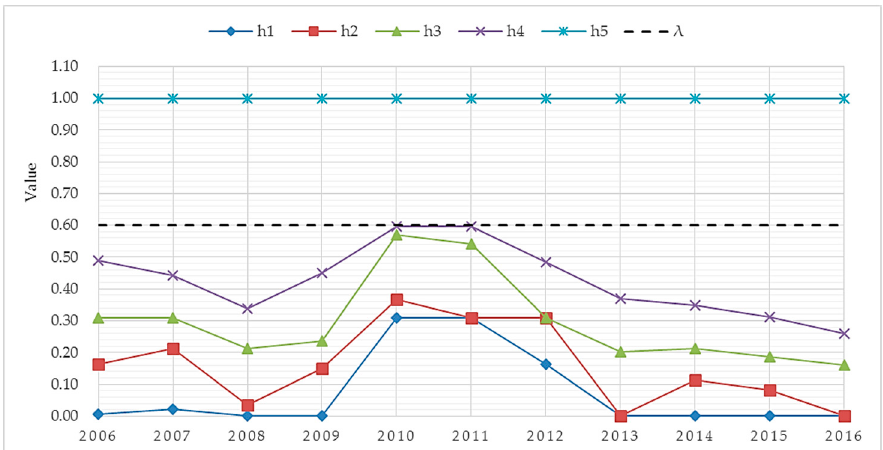
Figure 7. Cumulative connection degree trends for the state subsystem from 2006 to 2016.